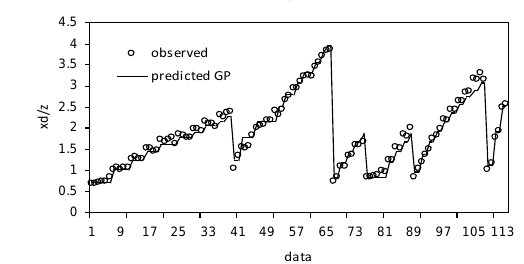
Figure 17. GP estimations of h d /z versus measured ones